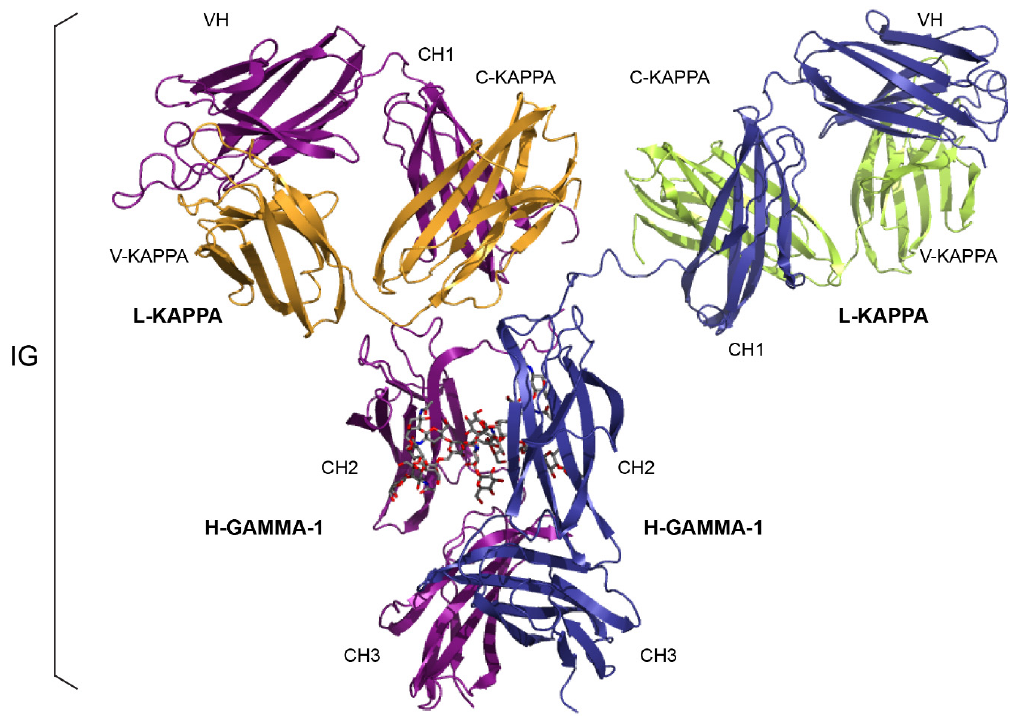
Figure 1. An immunoglobulin (IG) or antibody. The structure is that of the antibody b12, an IgG1-kappa, and so far the only complete human IG crystallized (IMGT ® http://www.imgt.org, IMGT/3Dstructure ‐ DB > Entry code (PDB): 1hzh). H ‐ GAMMA ‐ 1 and L ‐ KAPPA (for the chains), VH, CH1, CH2, CH3, V ‐ KAPPA and C ‐ KAPPA (for the domains) written in capital letters are IMGT standardized labels (DESCRIPTION) [1,34,35]. H ‐ gamma1 and L ‐ kappa, written in small letters in the text, corresponf to the IMGT standardized keywords (IDENTIFICATION) [1,30,31]. The two light chains are identical and the two heavy chains are identical (the different colours are only used for a better visualization). (With permission from M ‐ P. Lefranc and G. Lefranc, LIGM, Founders and